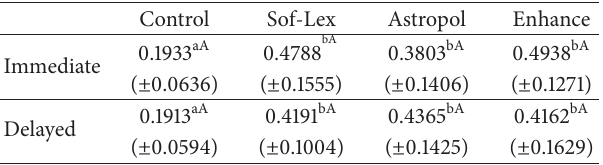
Table 2: Comparison of roughness (Ra, 𝜇 m) means ( ± standard deviation) for the finishing and polishing systems studied according to application time.